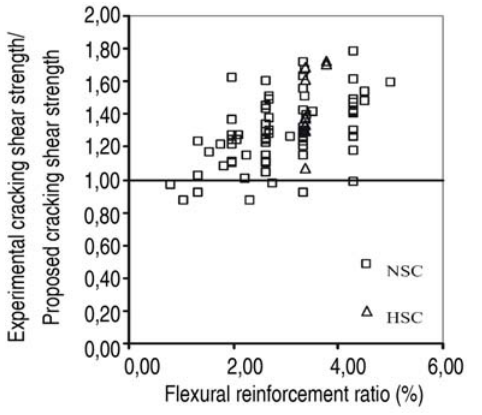
Fig. 6. Comparing experimental cracking shear strength values with proposed cracking shear strength of Eq (15) for various shear span-to-depth ratios